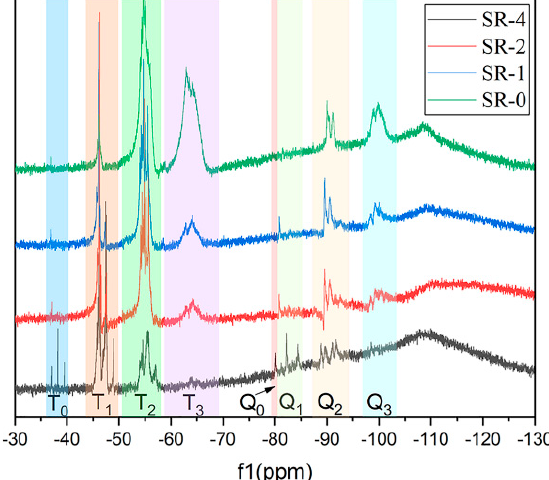
Processes 2020 , 8 , x FOR PEER REVIEW Figure 2. 29 Si NMR of the silicon resins. Figure 2. 29 Si NMR of the silicon resins.